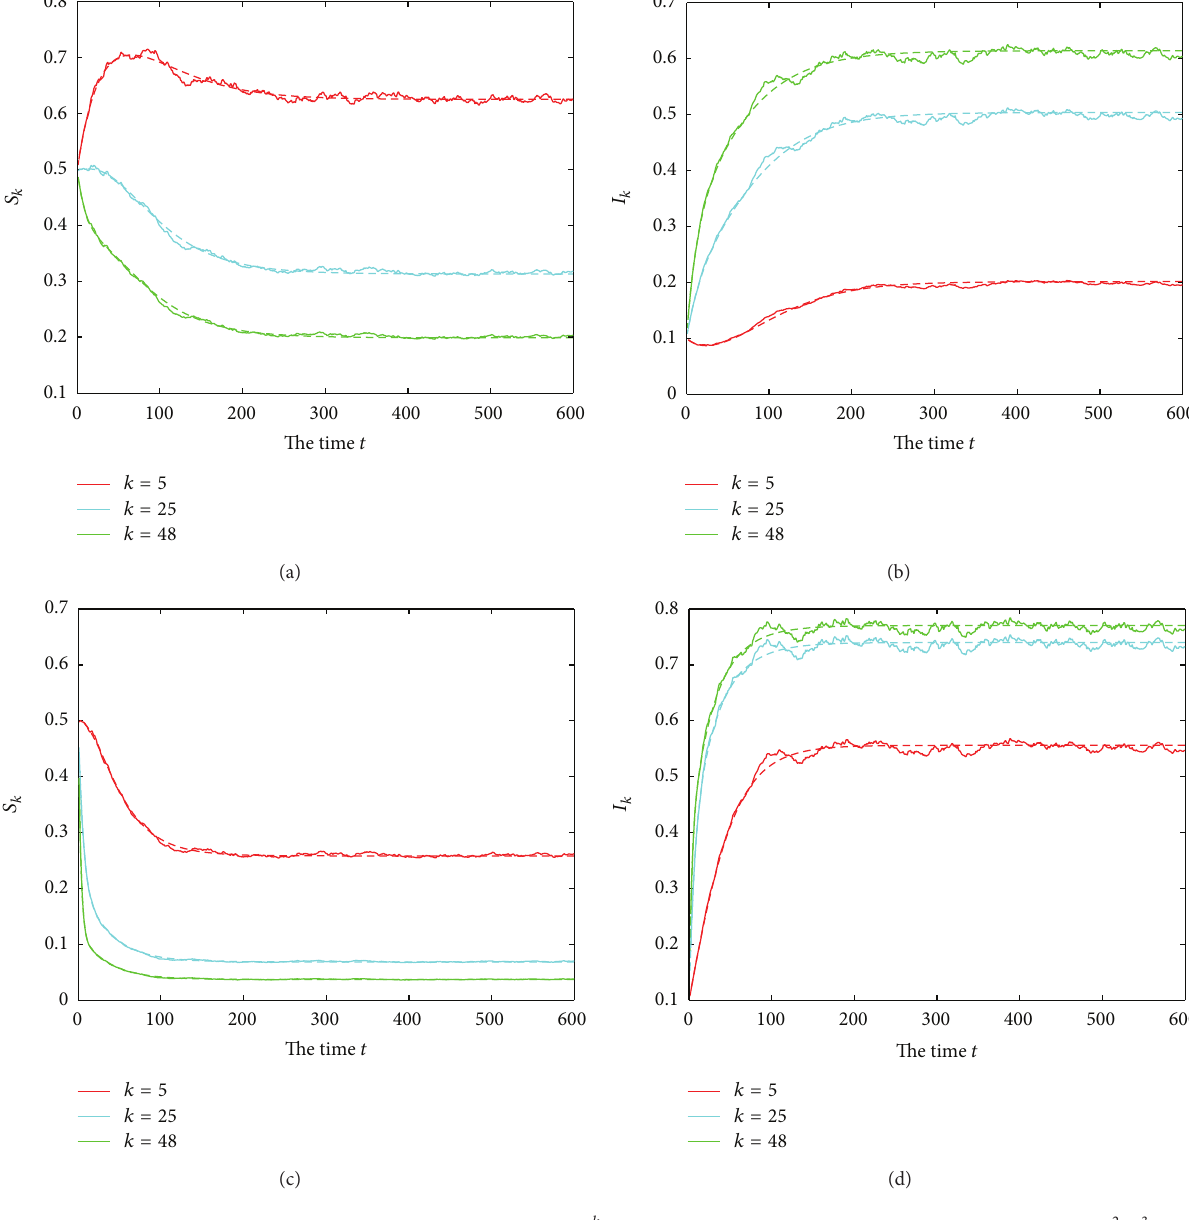
Figure 3: 𝜆 = 0.08 , 𝜎 𝑘1 = 0.01 , 𝜎 𝑘2 = 0.01 , 𝑅 0 ≥ 1 . (a), (b) 𝑃(𝑘) = 𝑚 𝑘 exp (−𝑚)/𝑘! , 𝑚 = 6 , 𝑅 0 = 1.5054 ≥ 1 ; (c), (d) 𝑃(𝑘) = 2𝑚 2 𝑘 −3 , 𝑚 = 3 , = 2.9027 ≥ 1 𝑅 0